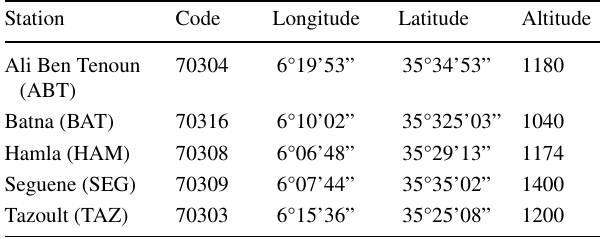
Table 1 Coordinates of the selected stations Station Code Longitude